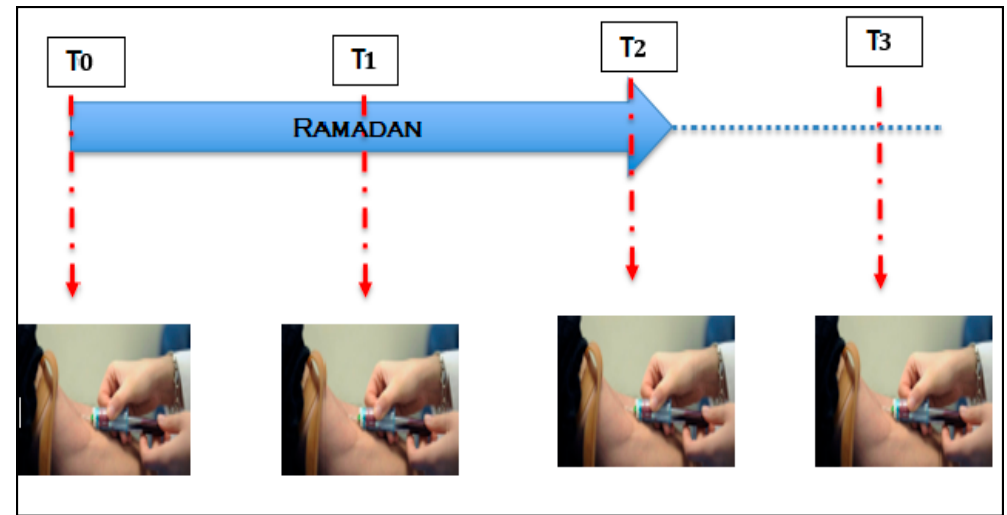
Figure 2. Time points for measurements of anthropometric characteristics and blood sampling at T0 (24 h before the start of Ramadan), T1 (15th day of Ramadan,), T2 (the day after the end of Ramadan) and T3 (21 days after the end of Ramadan).